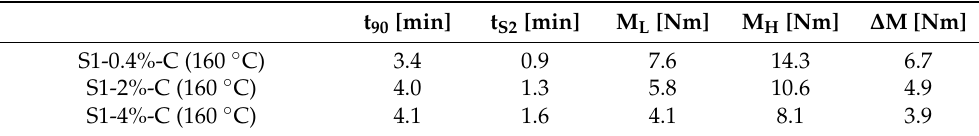
Table 1. Results of rheometer curves recorded at 180 ◦ C for samples S1-0.4%-C (160 ◦ C), S1-2%-C (160 ◦ C), and S1-4%-C (160 ◦